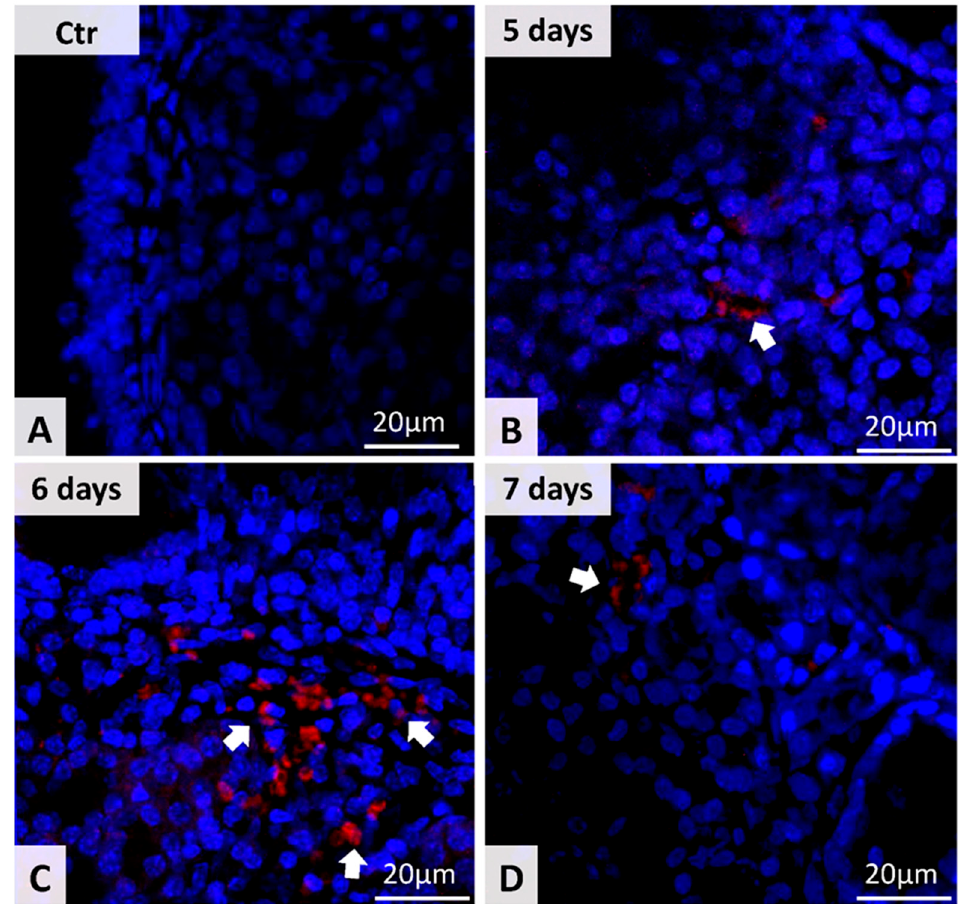
Figure 2. MSC detection in CSLM analysis ( A ) Control group ( B ) 5 days after MSCs administration on the CRS mouse model. ( C ) 6 days after MSCs administration on the CRS mouse model. ( D ) 7 days after MSCs administration on the CRS mouse model. White arrow indicates the Fluorescent signals for CD44.